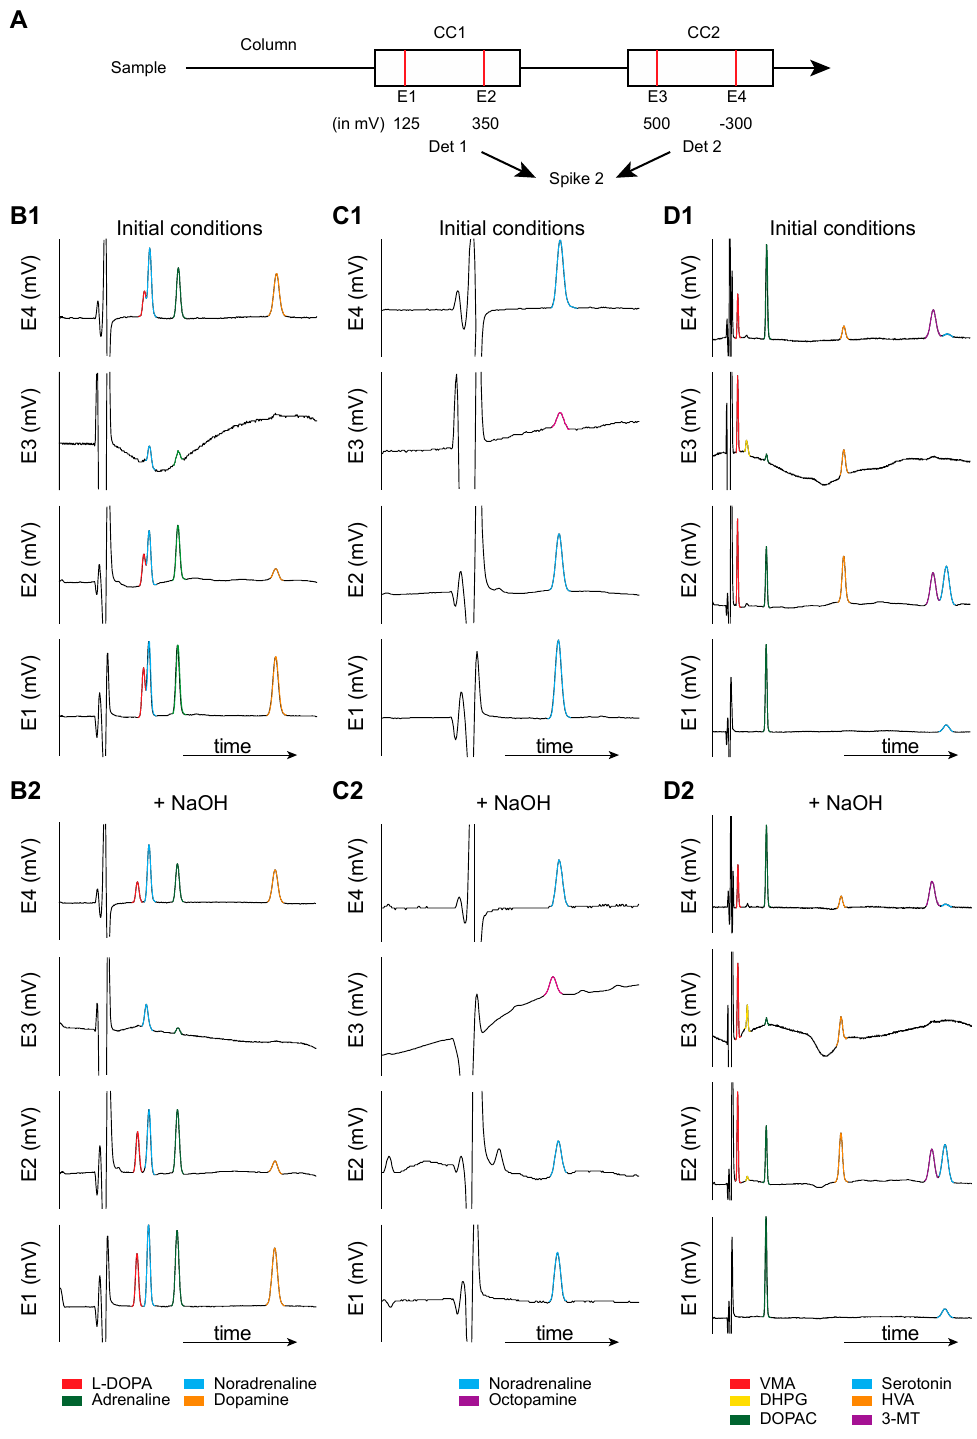
Figure 4. Chromatographic conditions for monoamines measurement: Focus on NA. The purpose of these chromatograms is to illustrate that the measurement of NA using classical procedures, which is not an easy task, because several species can be eluted at the same time. ( A ) Experimental procedures. We used classical procedures for the chromatographic conditions, as recently published [94], with some modifications as regards to the electrochemical detection. A conditioning cell (5020, ESA) was placed before the manual injector and set at + 450 mV. Then, after the column, two coulometric cells (5011, ESA; two electrodes each) were placed in series, each cell being connected to one coulometric detector (CoulochemII, ESA). The potential at the four electrodes was as follows: + 125, + 350, + 500, and − 300 mV (reduction). The detectors were connected to the CED 1401 interface (Cambridge Electronic Design